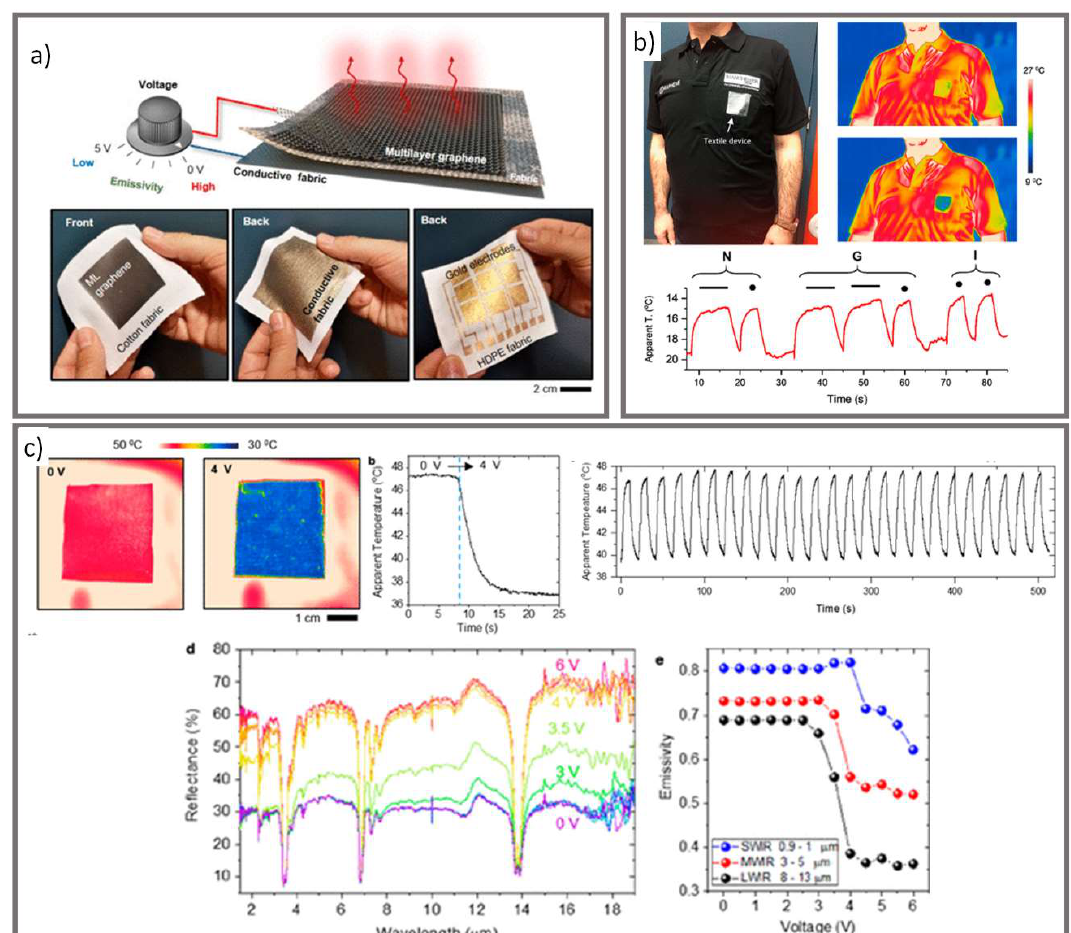
Figure 10. ( a ) Schematic of the adaptive IR textile consisting of multilayers of graphene, fabric, and back gold electrode layer. ( b ) IR communication t-shirt. By changing the emissivity of the patch on the t-shirt with a specific modulation, letters can be sent in morse code. ( c ) IR images of the ion intercalation adaptive optical textile in the high (0 V) and low (4 V) emissivity states while on a hot plate at 55 °C, change in apparent temperature after application of a 4 V voltage, change in apparent temperature under repeated voltage cycles, IR reflection spectra for different applied voltages and short-, medium-, and long-wavelength IR emissivity as a function of the applied voltage (reprinted from [66] with permission from American Chemical Society).